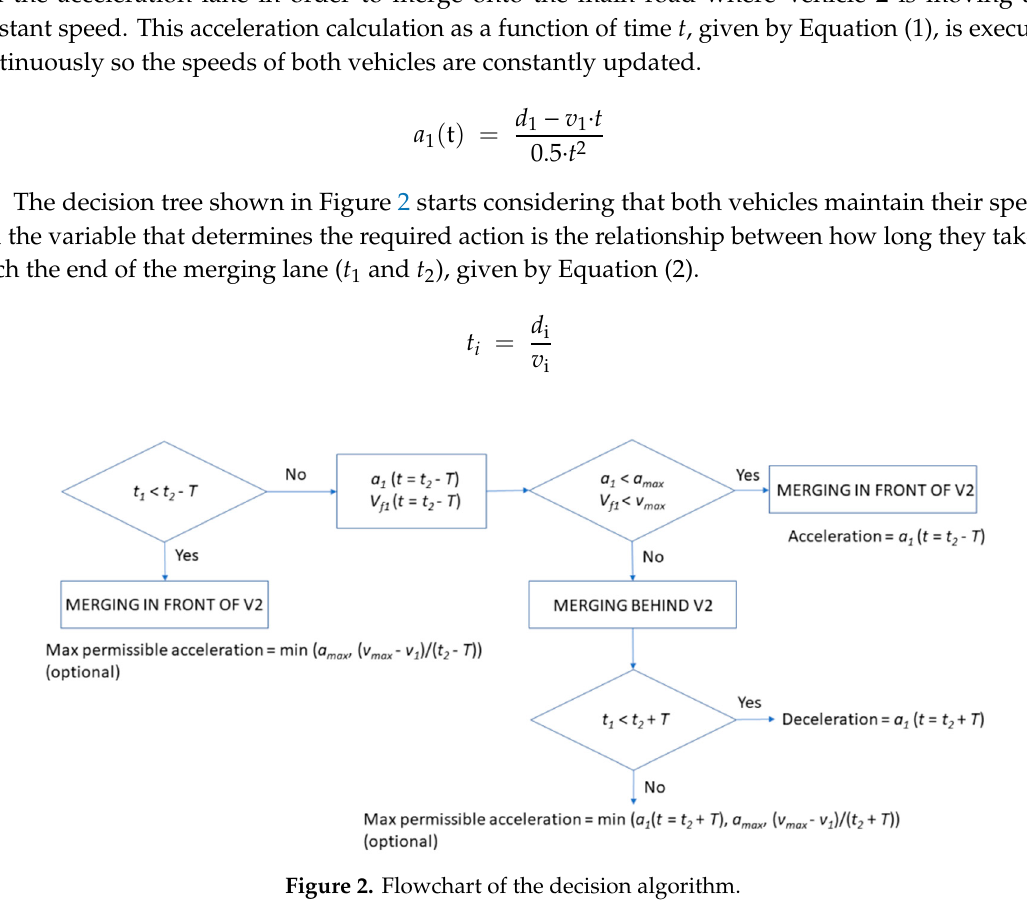
Figure 2. Flowchart of the decision algorithm.